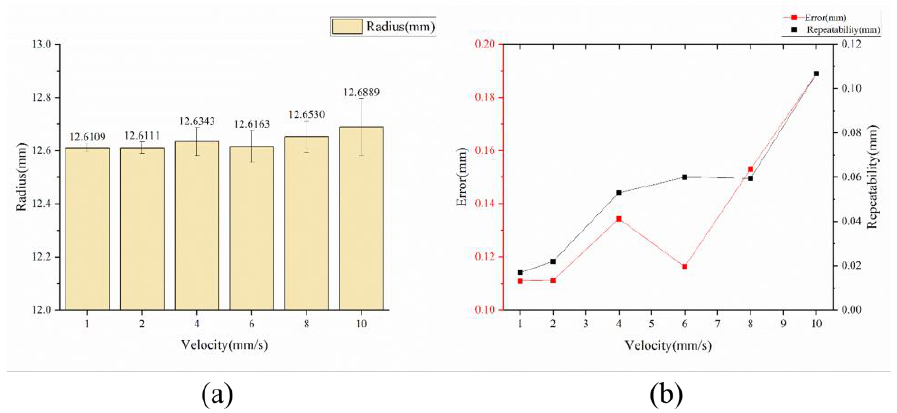
Figure 11. The mean value ( a ), error, and repeatability ( b ) of the radius of the calibration ball measured at different approach velocity.